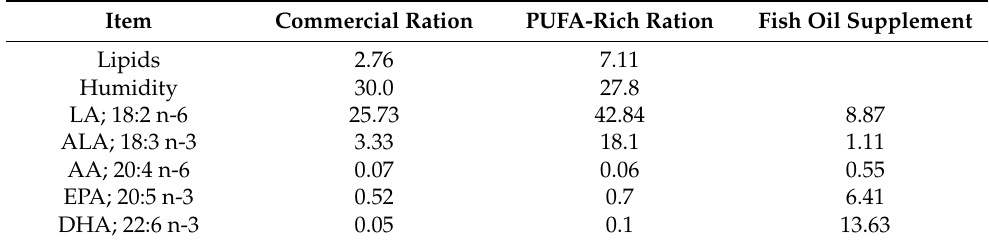
Table 2. Percentage of fatty acids in the rations administered to sheep and in the supplement with fish oil